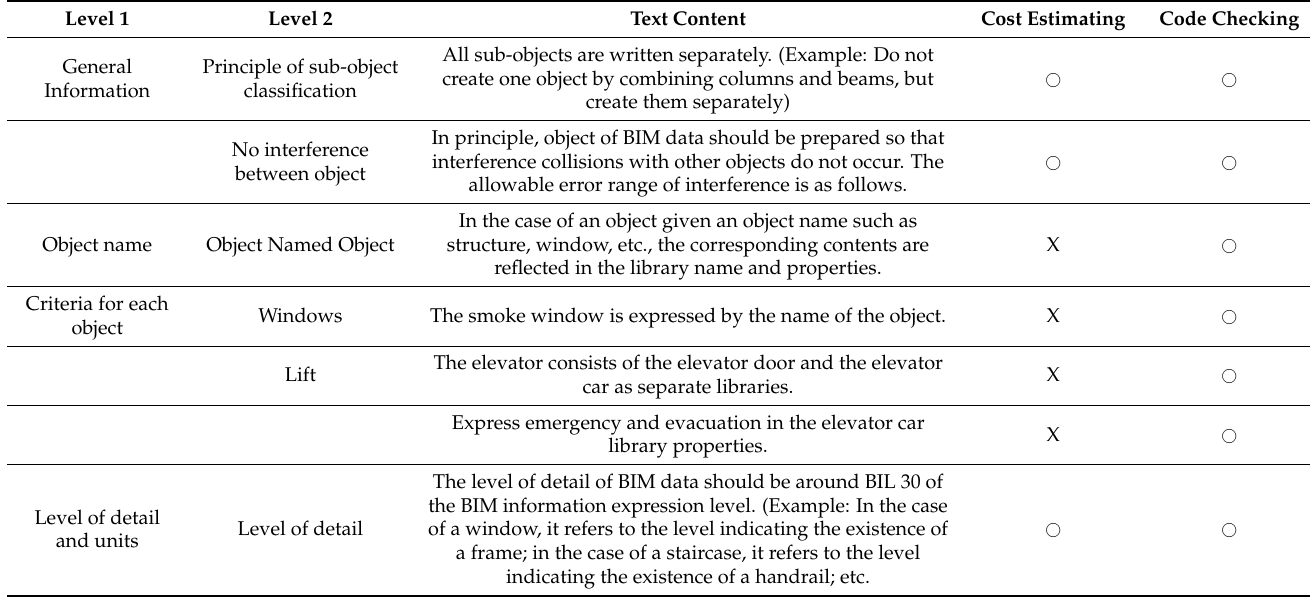
Table 7. Authoring Model Layer—Part of the Authoring Guide.